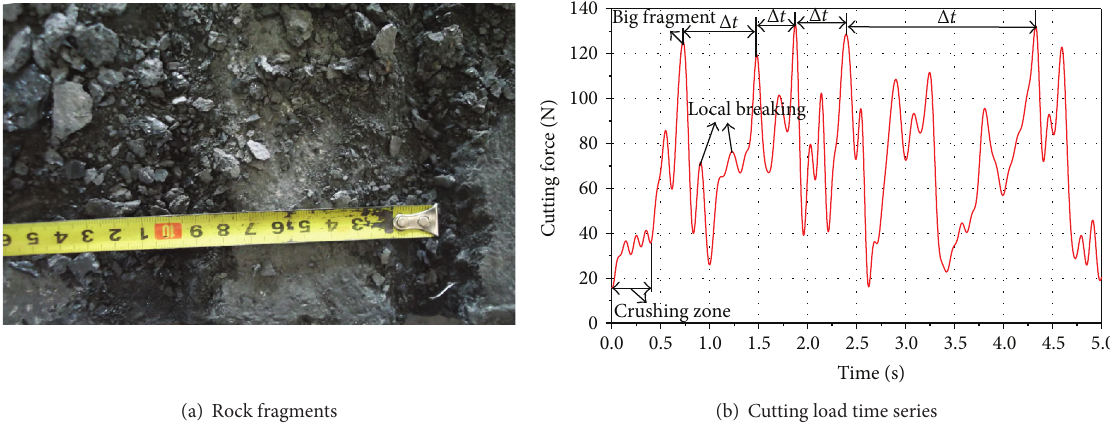
Figure 3: Cutting load time series and fragments Δ